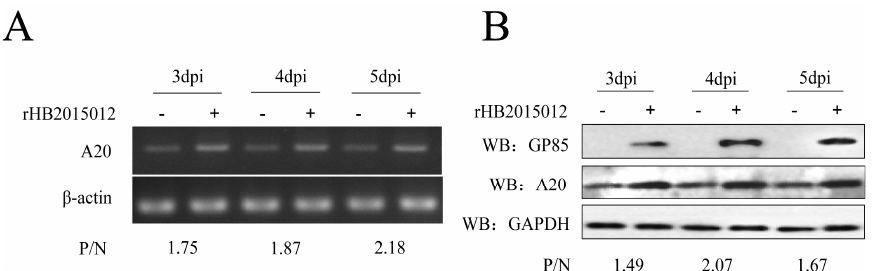
Figure 1. ALV-A (rHB2015012) upregulates A20 expression. ( A ) Detecting ALV-A promoted A20 expression using semi-quantitative PCR. ( B ) Detecting ALV-A promoted A20 expression using Western blotting.